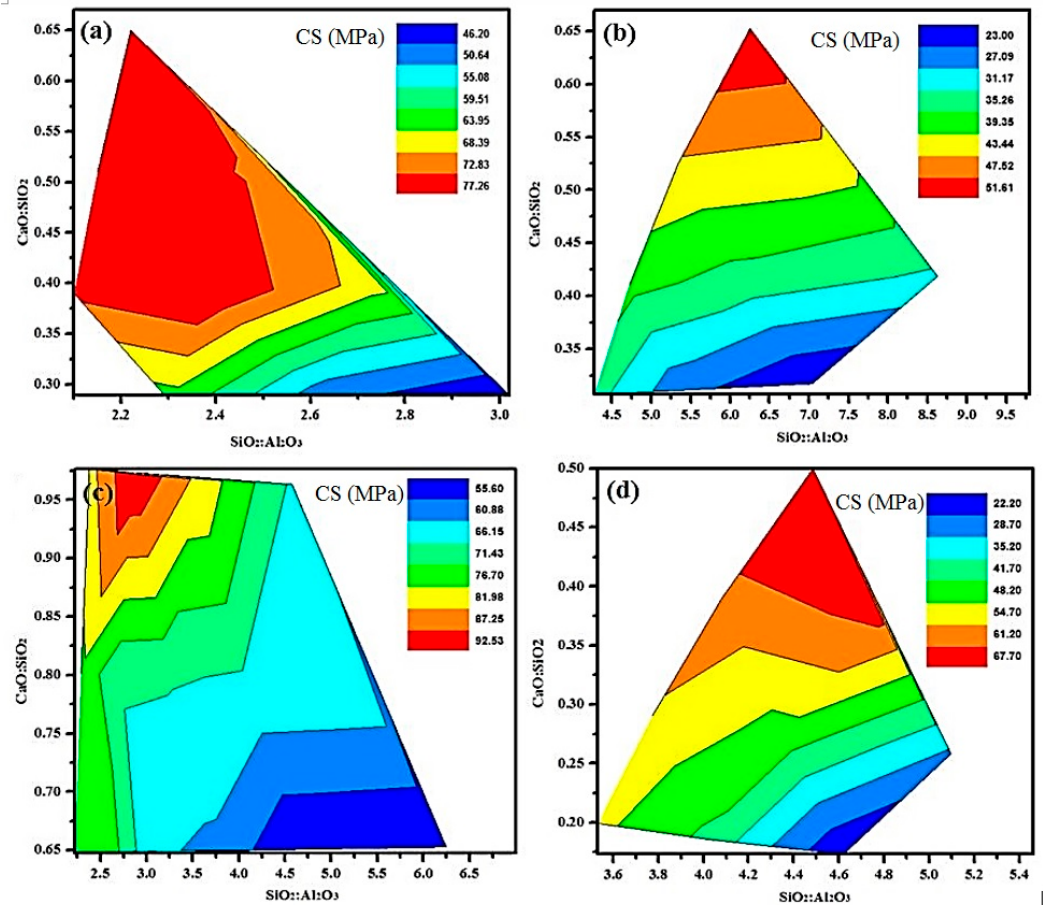
Figure 7. Effect of varying CaO:SiO 2 and SiO 2 :Al 2 O 3 on the compressive strength of AAMs containing a high volume of ( a ) FA ( b ) POFA ( c ) GBFS ( d ) WCP.